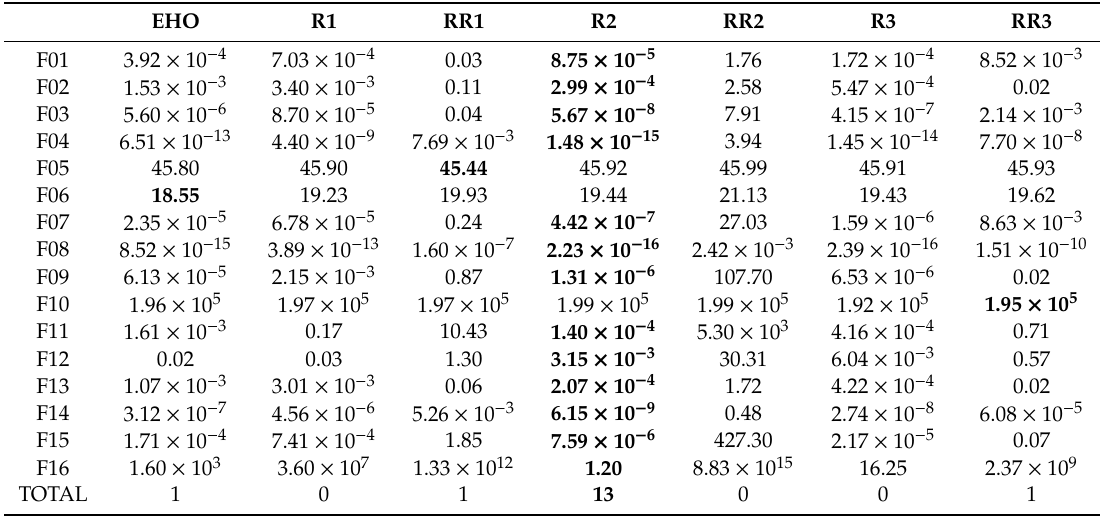
Table 8. Mean function values obtained by EHO and six improved methods with D = 500.